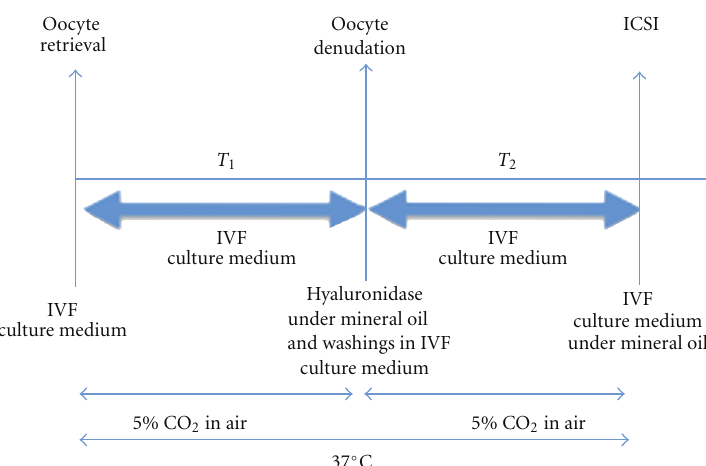
Figure 1: Schematic representation of the two timings T 1 and T 2 . T 1 : Time elapsed between oocyte retrieval and denudation. T 2 : Time elapsed between oocyte denudation and